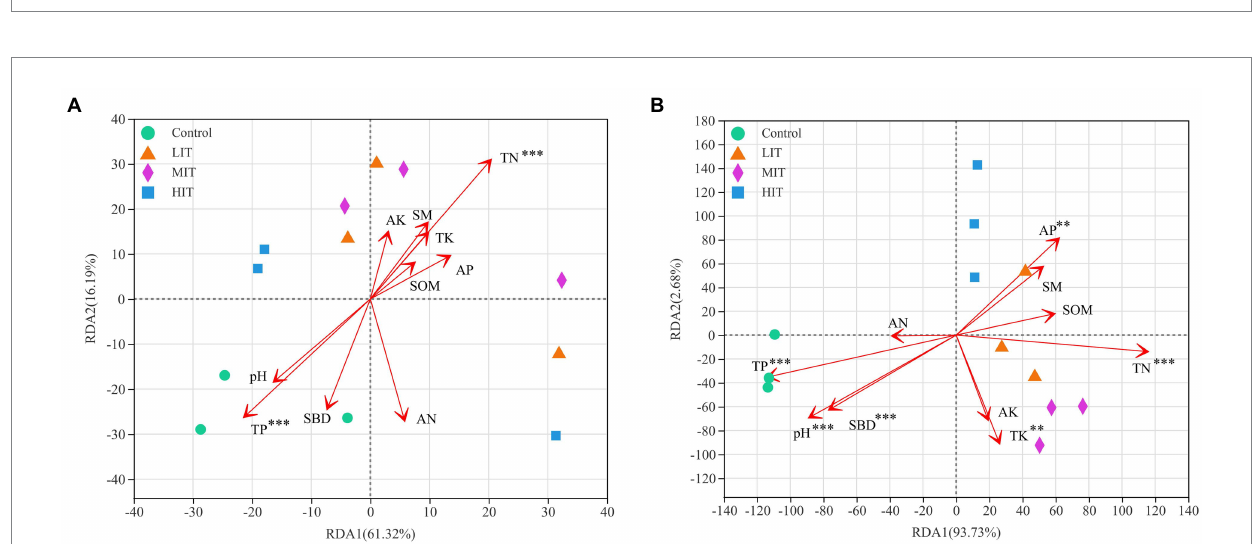
FIGURE 6 RDA of abundant bacterial (A) and fungal (B) communities at the genus level and soil properties for the soil samples from four different thinning treatments in C. japonica var. sinensis plantations. SM, soil moisture; SBD, soil bulk density; SOM, soil organic matter; TN, TK, TP, AN, AK, and AP, contents of total nitrogen, total potassium, total phosphorus available nitrogen, available potassium and available phosphorus, respectively. * p < 0.05, ** p < 0.01, *** p <